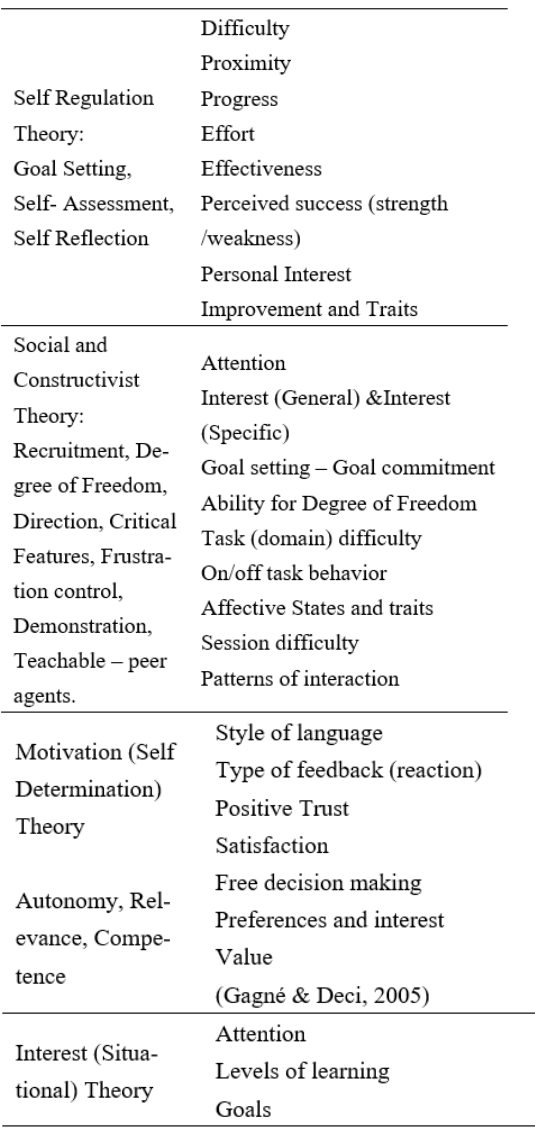
Table 2. Followed theories for